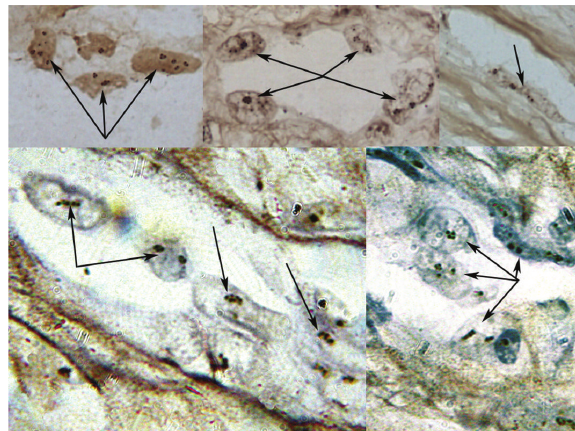
Figure 2: The number of AgNORs of vascular endothelial cells in sarcoma, as estimated using AgNO 3 . The number of argyrophilic granules in endotheliocyte nuclei from di ff erent areas of microves- sels is more than 2-3 granules per 2 ring-shaped nucleoli. The arrows are pointing at endothelial cells with argyrophilic